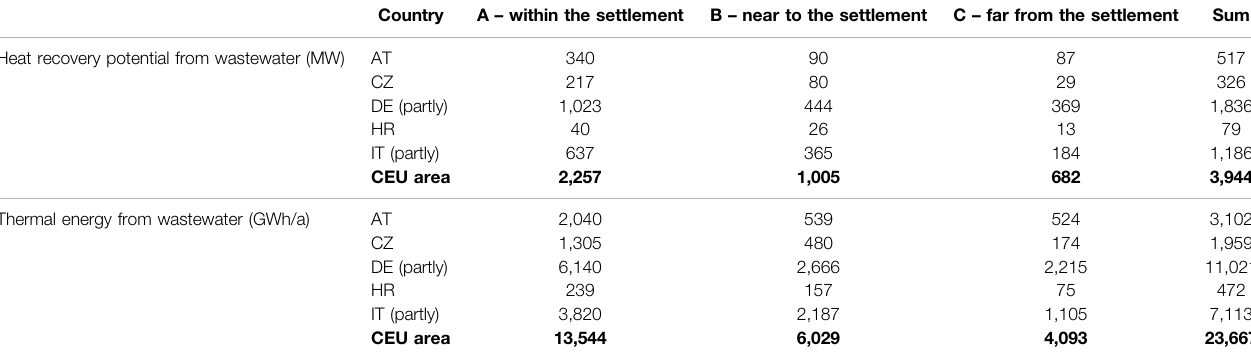
TABLE 7 | Estimation of wastewater heat recovery potentials (MW) and thermal energy from wastewater (GWh/a) in context to the adjacent settlement structures (own illustration). Country A – within the settlement B – near to the settlement C – far from the settlement